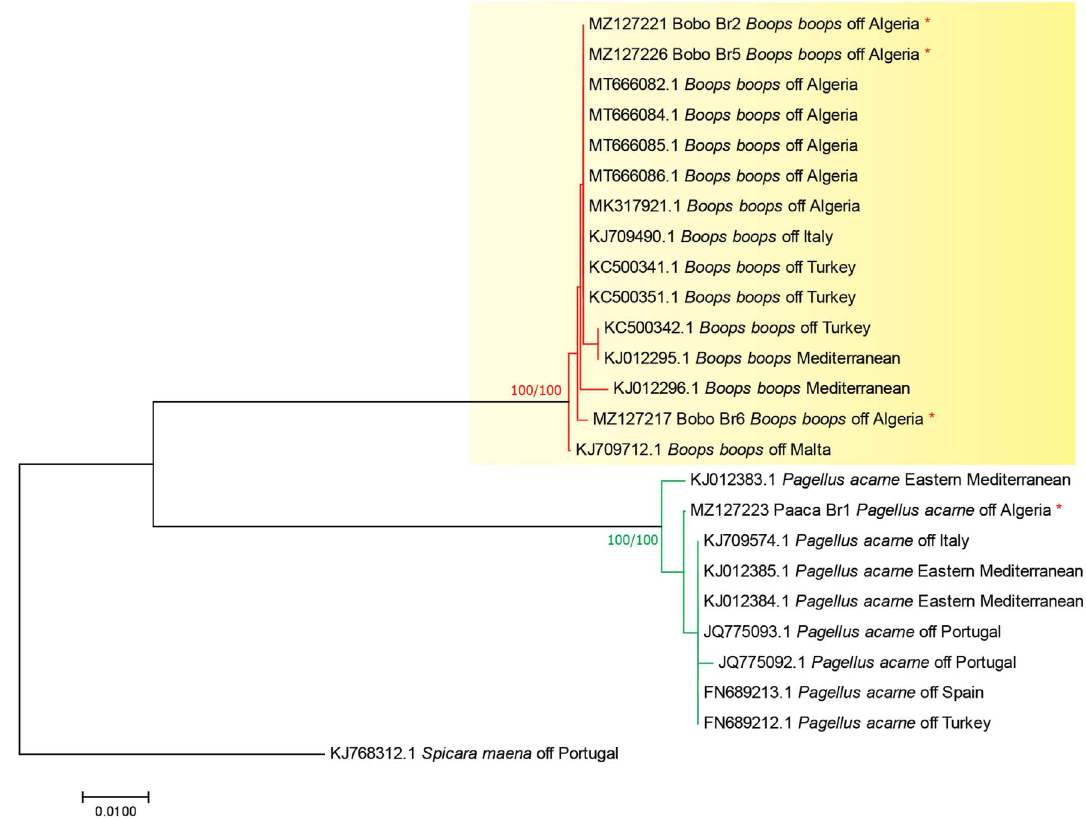
Figure 2. Molecular phylogenetic analysis based on maximum likelihood, inferred from COI sequences of Boops boops in relation to other hosts of Cyclocotyla bellones . The tree is drawn to scale, with branch lengths measured in the number of substitutions per